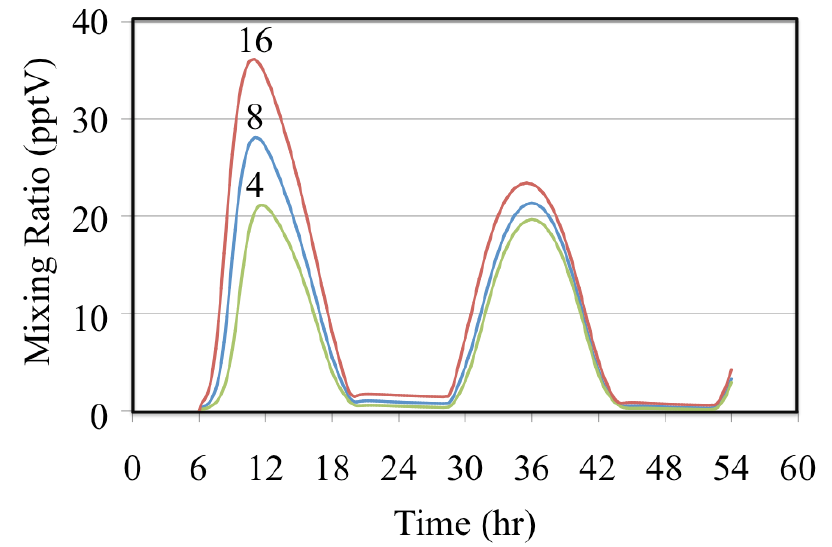
Figure 8. Hydroperoxy radical, HO 2• , mixing ratios are shown for the ethene cases. The number indicates the initial VOC/NO ratio in x